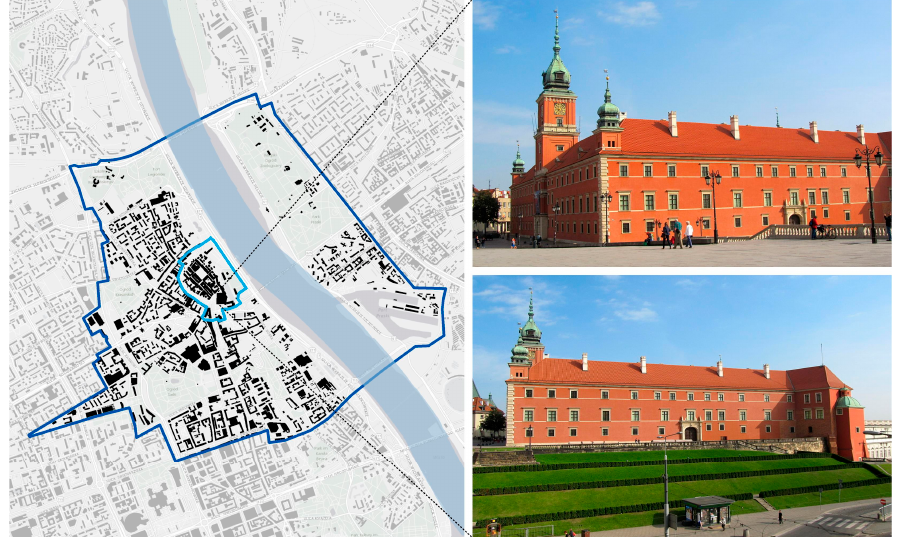
Figure 1. The map of Warsaw showing the location of the Royal Castle in the context of the UNESCO World Heritage Site (the inner ring) with its buffer zone (the outer ring). On the right, two photographs of the castle are shown (images by Geociekawostki, distributed in Wikimedia Commons under a CC-BY-SA-3.0-PL license).